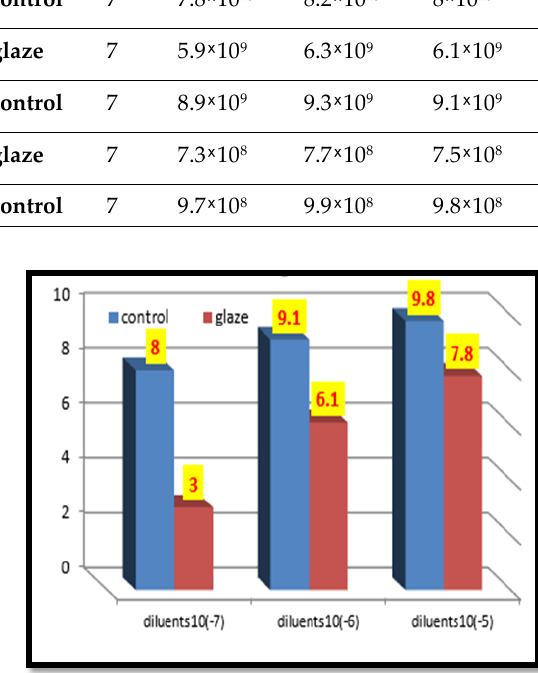
Figure 5: Bar chart for mean value of three dilutions for viability test